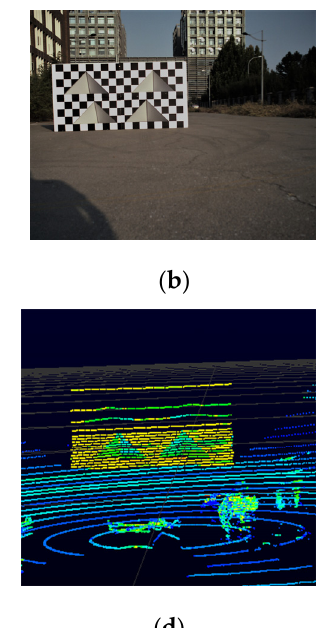
Figure 6. Experimental system and test scenario.